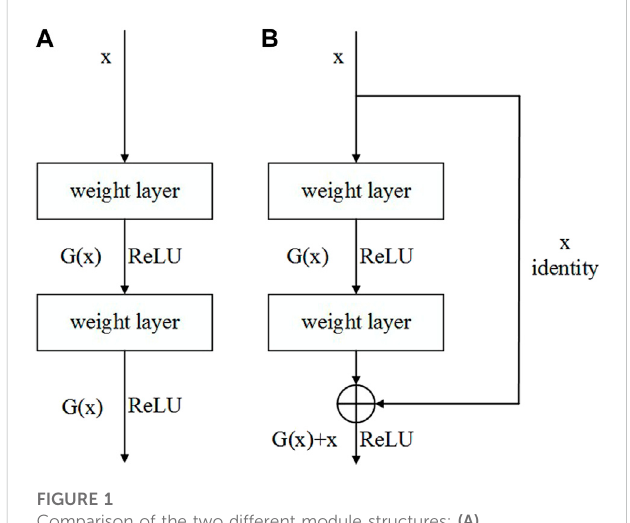
FIGURE 1 Comparison of the two different module structures: (A) convolution module and (B) residual